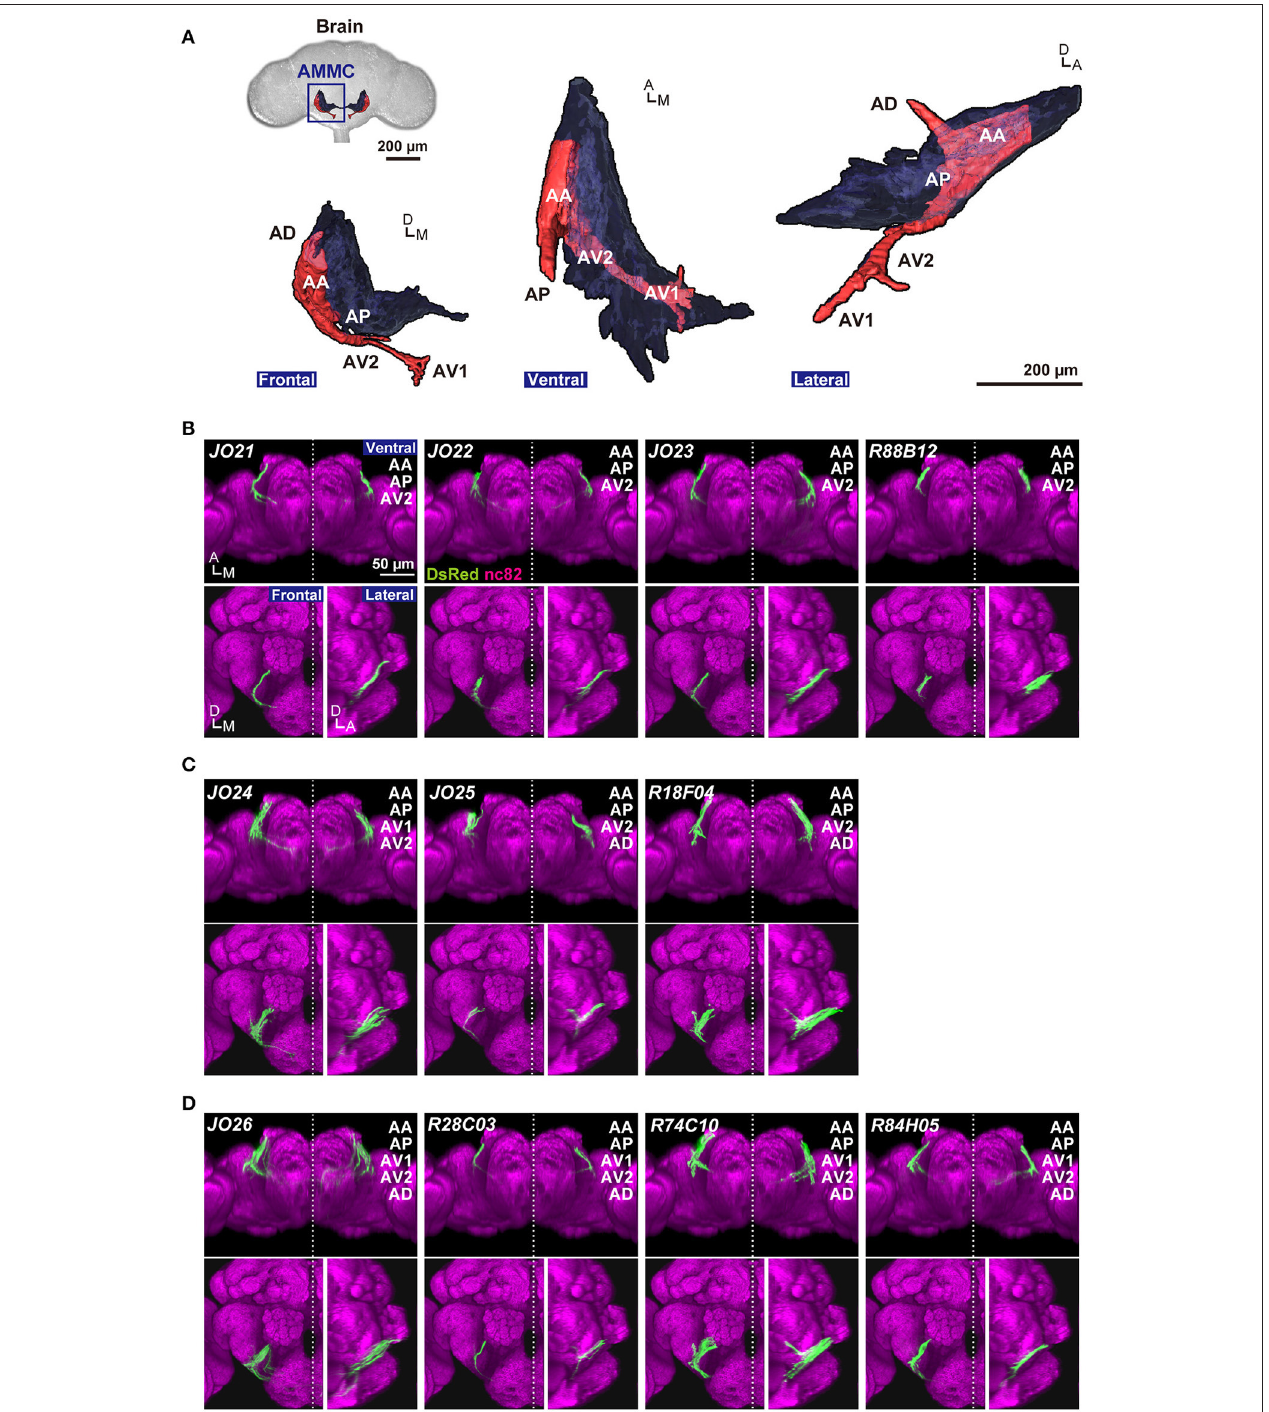
FIGURE 1 | Anatomy of JO-A neurons. (A) Frontal, ventral, and lateral views of 3D-reconstructed AMMC zone A in a fly brain. Zone A and other AMMC zones are shown in red and black, respectively. Five subareas in the zone A (subareas AA, AP, AV1, AV2, and AD) represent the projection target of JO-A neurons in the brain. (B–D) GAL4 strains that label JO-A neurons ( JO-A GAL4 strains). Labeled subareas in each strain are shown at the upper-right of the panel. Ventral, frontal, and lateral views of the brain of each strain that labels three (B) , four (C) , and five subareas (D) are shown. All images were registered to a template brain. Green and magenta signals show the DsRed-labeled neurons and nc82-labeled neuropils, respectively. Signals of cells that were not relevant to JO-A neurons were manually erased from the original images for clarity. Original labeling patterns are shown for JO strains (Kamikouchi et al., 2006) and FlyLight database (http://flweb.janelia.org/cgi-bin/flew. cgi) for FlyLight strains. A, anterior; D, dorsal; M, medial. Images in panel (A) were modified from Ishikawa and Kamikouchi (2016) with permission.